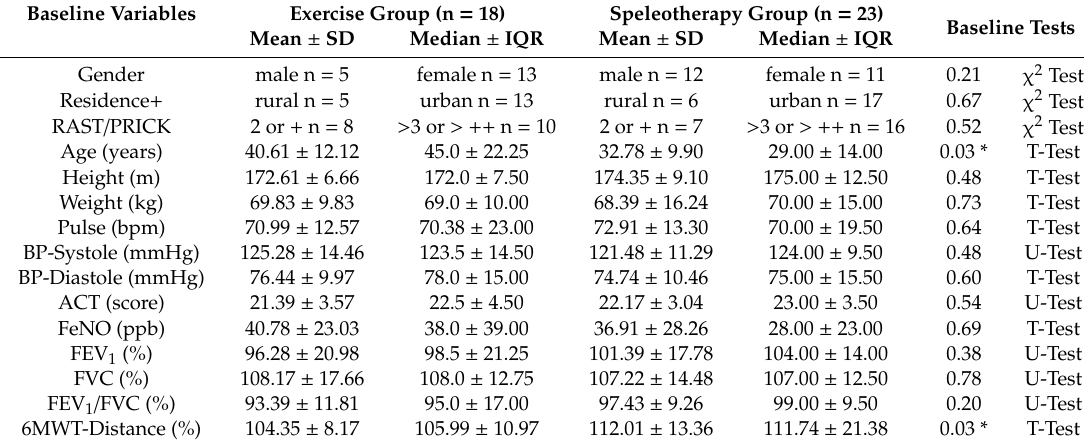
Table 1. Baseline characteristics of the study population.